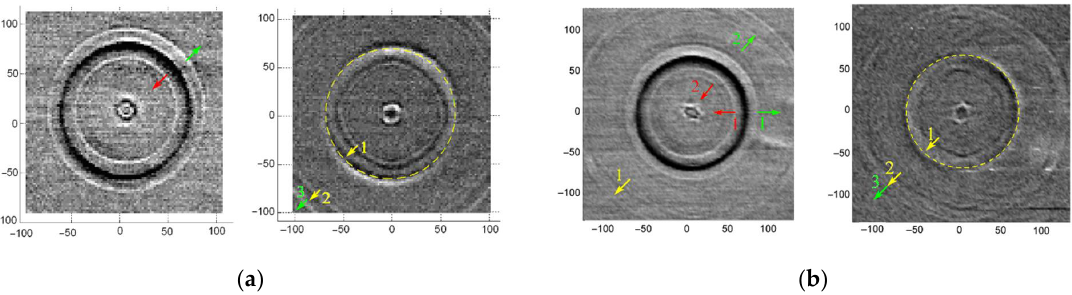
Figure 4. Converging SAW on silicon surface covered by aluminium film at different time delay. ( a ) Silicon sample with orientation (001); ( b ) Silicon sample with orientation (111).